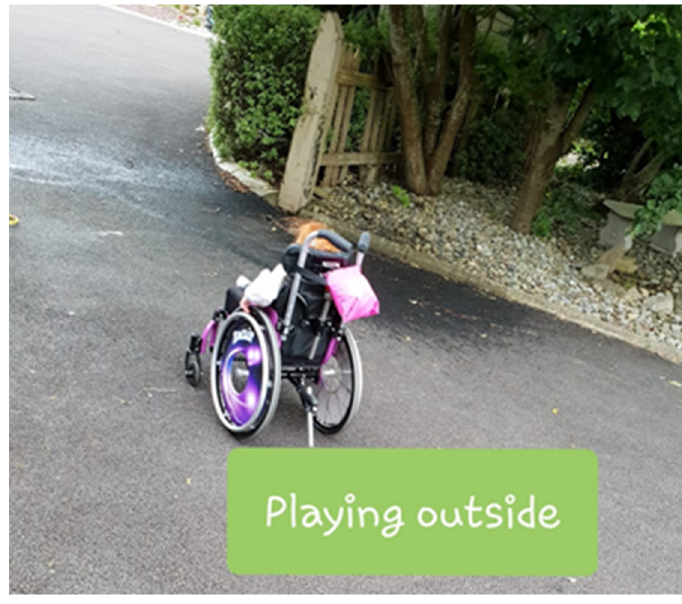
Figure 9. Rachel playing outside.